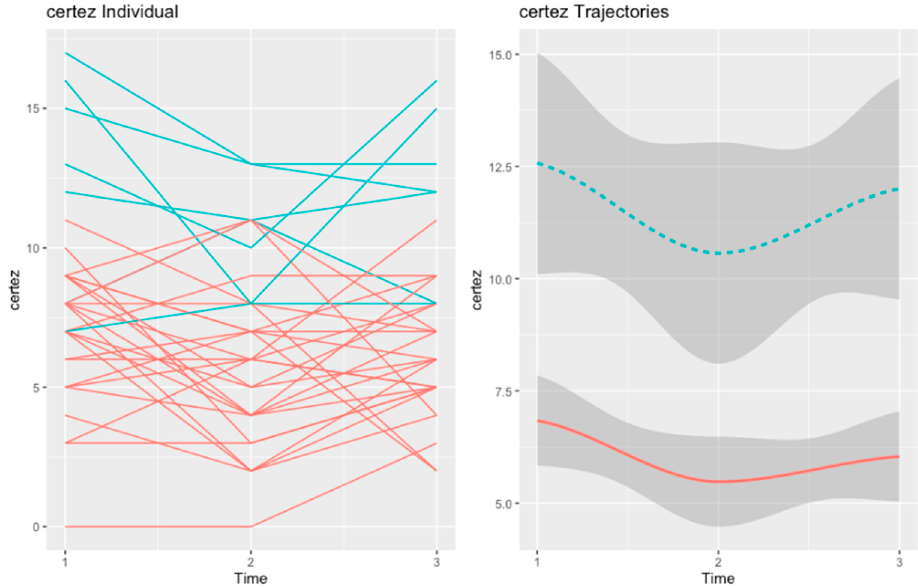
Figure 2. Trajectories of self-certainty in the MCT group: “Initial Decline” (in red, n = 22) and “Re- sponsive SC” (in blue, n = 6). “Responsive SC” (in blue, n =